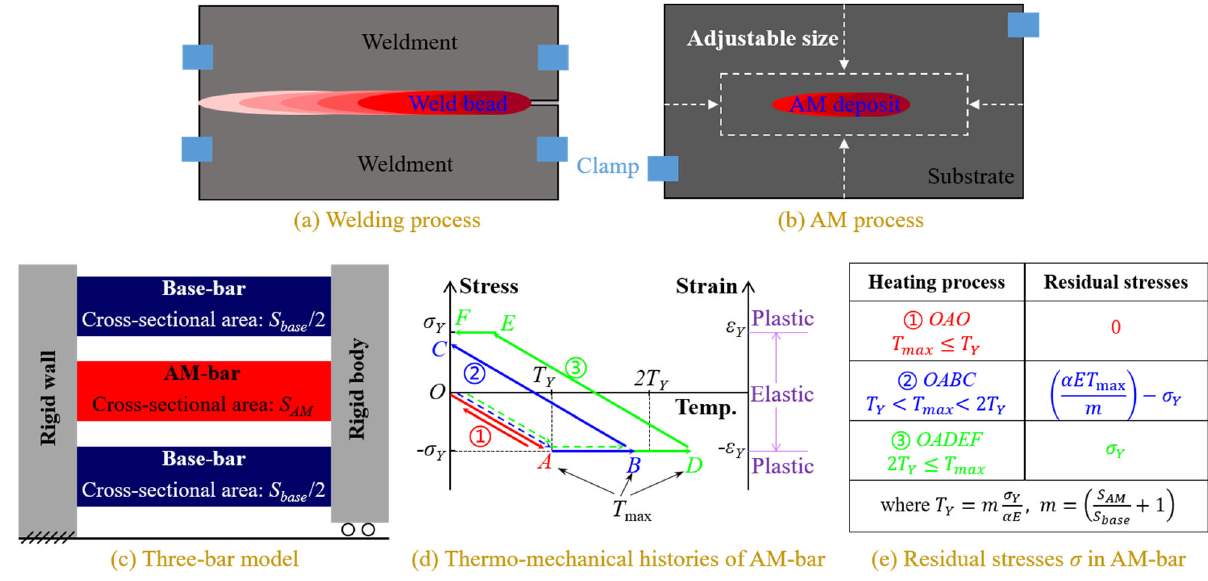
Figure 4. The formation of residual stresses in welding and AM processes.